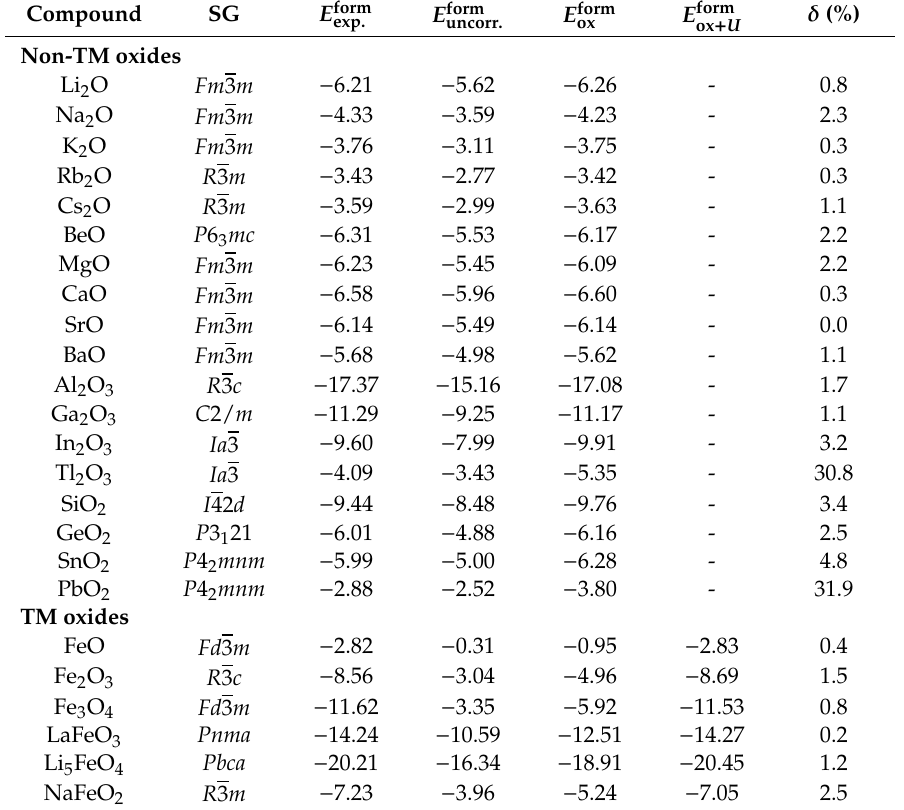
TableA1. Formationenergiesofoxidecompoundsintheirgroundstatecrystalstructure(specifiedbythe space group (SG) in Hermann-Mauguin notation) with respect to the elemental phases in eV per formula unit. Experimental standard enthalpies of the formation ( E form exp. ) are taken from References [38] (Rb 2 O and Cs 2 O); (Ga 2 O 3 , In 2 O 3 , GeO 2 , SnO 2 , and PbO 2 ) [37]; (Tl 2 O 3 ) [39]; (LaFeO 3 ) [53]; (Li 5 FeO 4 ) [60]; (NaFeO 2 ) [61]; and [36] (all other compounds). Calculated formation energies from DFT (non-TM oxides) and DFT + U for U Fe = 4 eV (TM oxides) are given without any corrections ( E form uncorr. ), considering the oxygen over-binding corrections ( E form ox ) and considering the oxygen over-binding together with DFT / DFT + U combination corrections ( E form ). δ denotes the absolute value of the relative deviation of ox + U the calculated and totally corrected value from the experimental value.